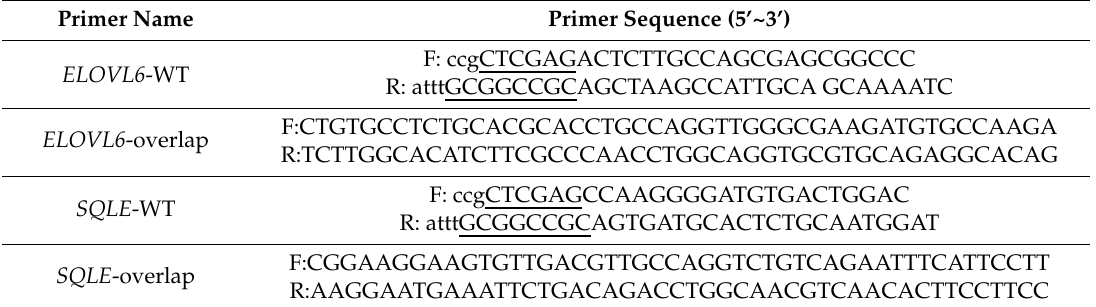
Table 1. Primer sequences used for dual-luciferase reporter vector